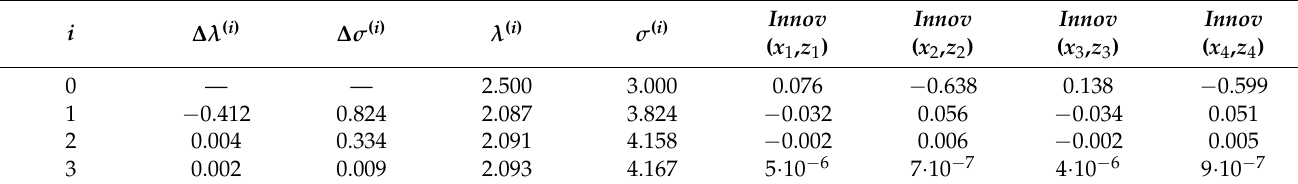
Table 5. FSM Iterates for the space-time constraint.